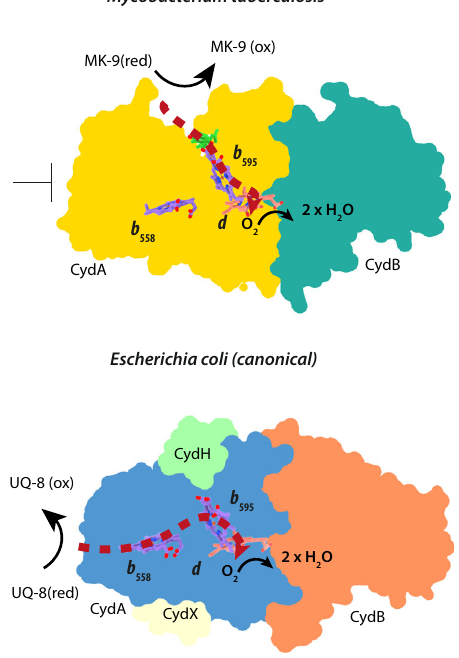
Fig. 5 Schematic overview of subunit composition and putative electron transfer pathways of cyt. bd Mtb and cyt. bd Ecoli . Red dashed lines illustrate proposed electron transfer routes. Subunits are indicated by different